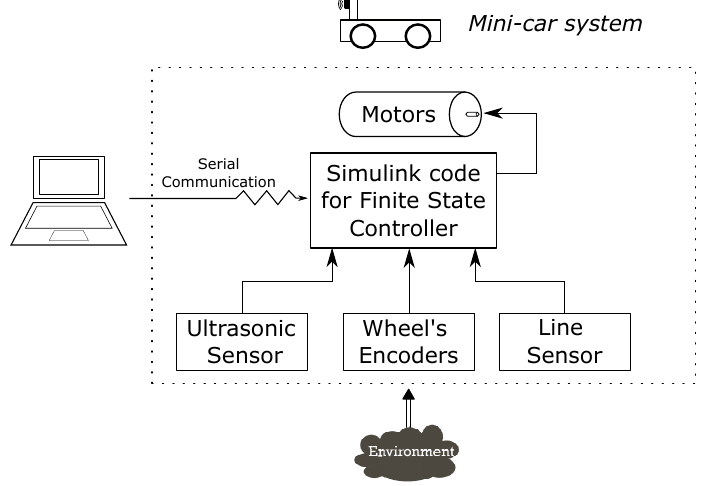
Figure 2. Scheme of the